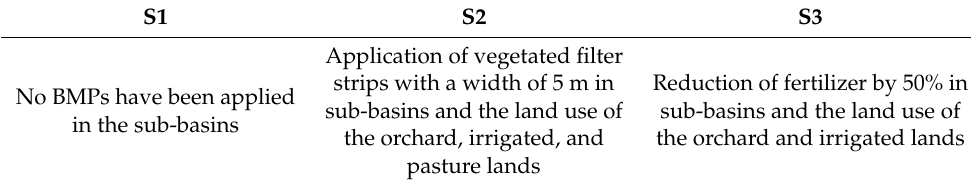
Table 8. Proposed scenarios for application in sub-basins.